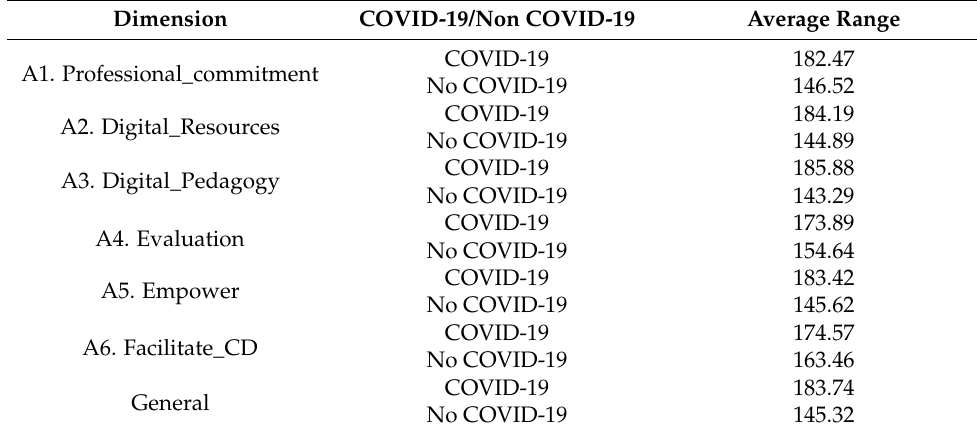
Table 5. Average ranges by dimensions in the pretest.